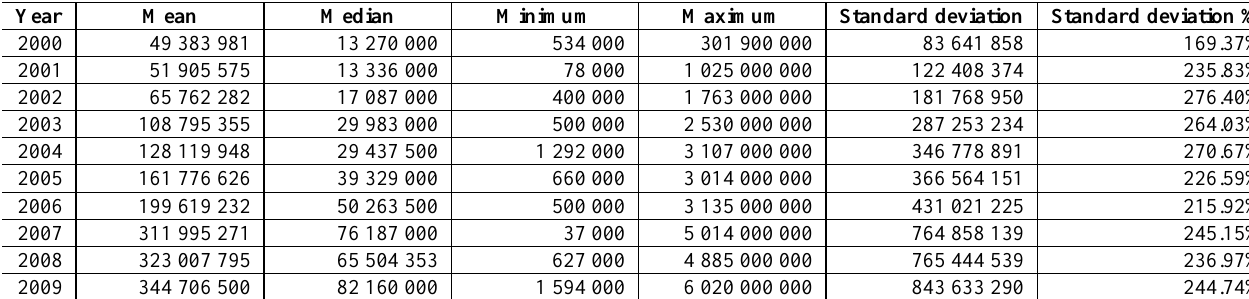
Table 2: Descriptive statistics on annual dividend payments